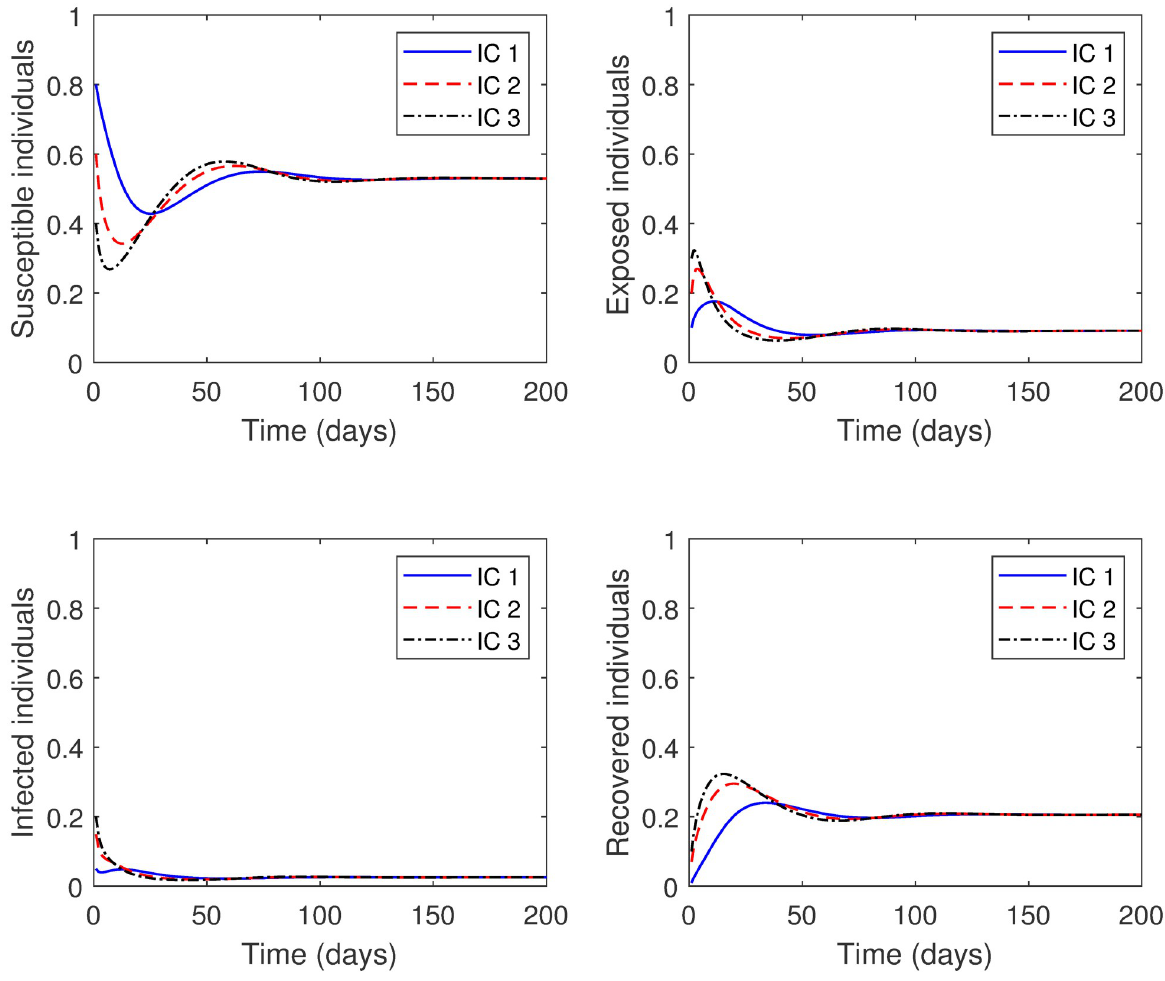
Fig 5. Numerical solution of model (1) with different initial conditions for R